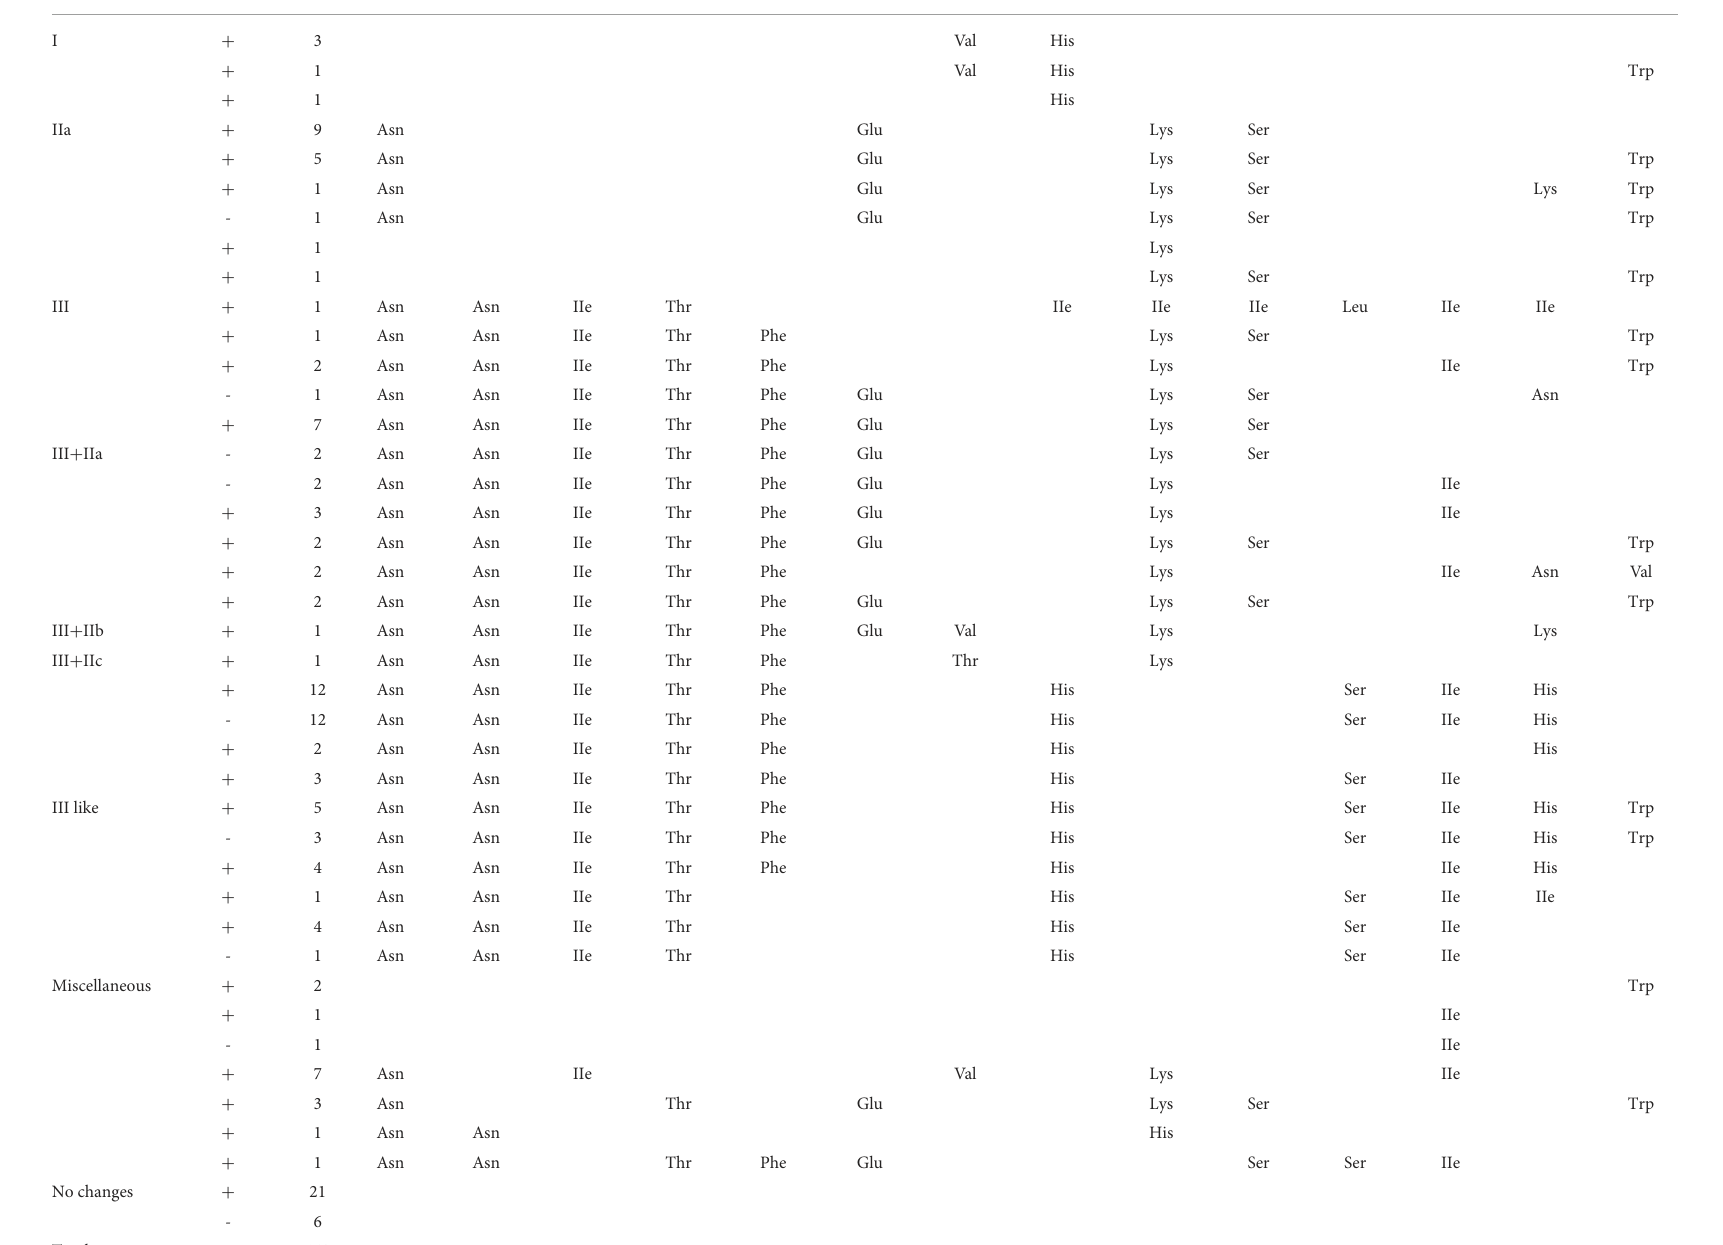
TABLE 3 Amino acid substitutions identified in the ftsI gene of H. influenzae